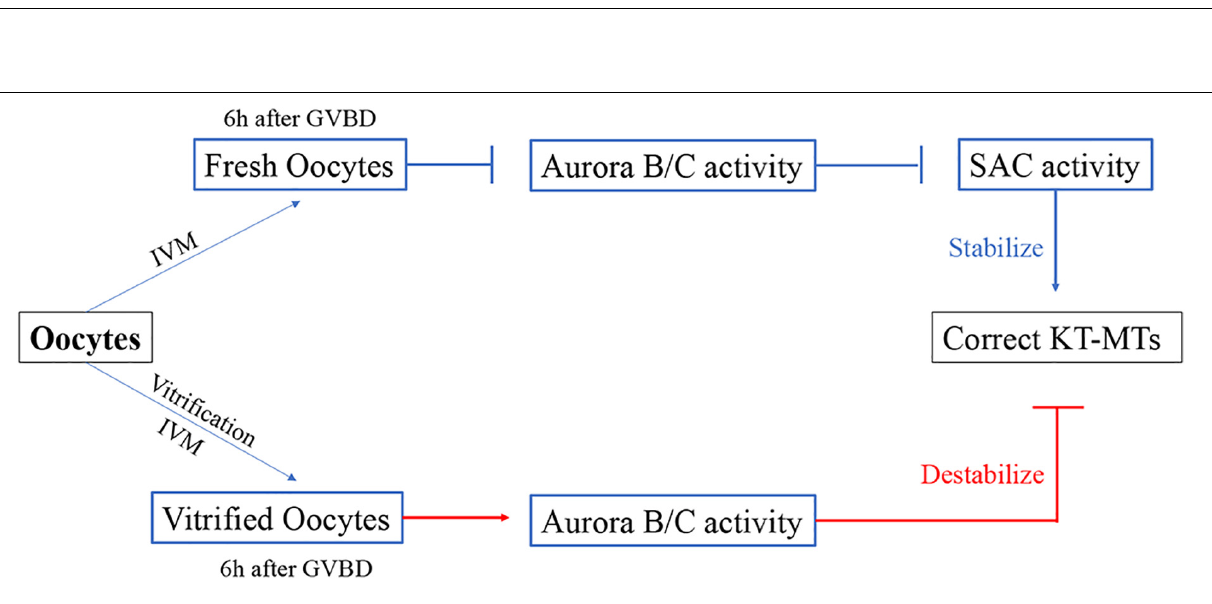
Frontiers in Cell and Developmental Biology |